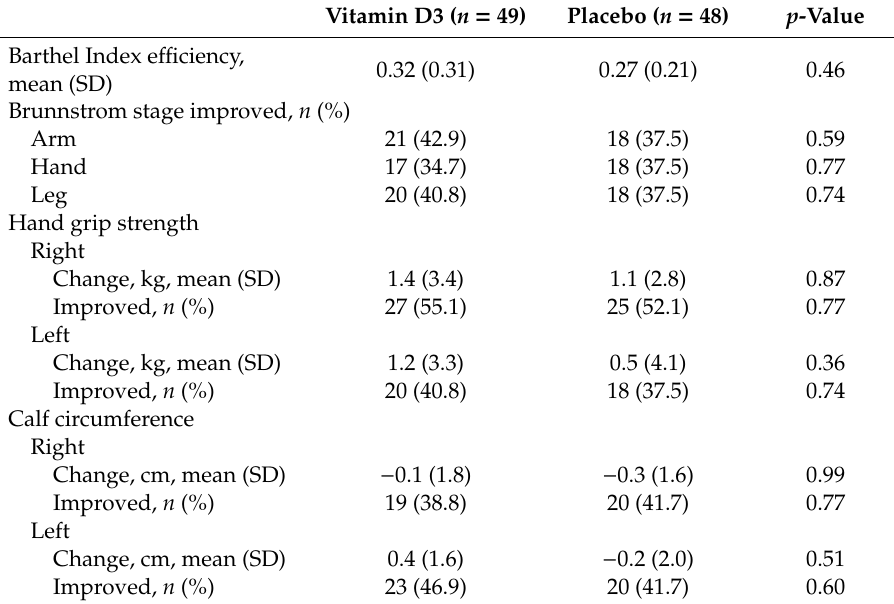
Table 3. Comparison of the secondary outcomes between the